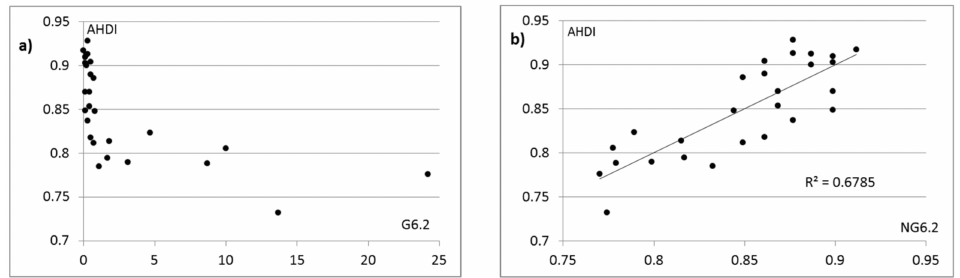
Figure 5. ( a ) Regularity G6.2. vs. AHDI and ( b ) regularity NG6.2 vs. AHDI. Developed by